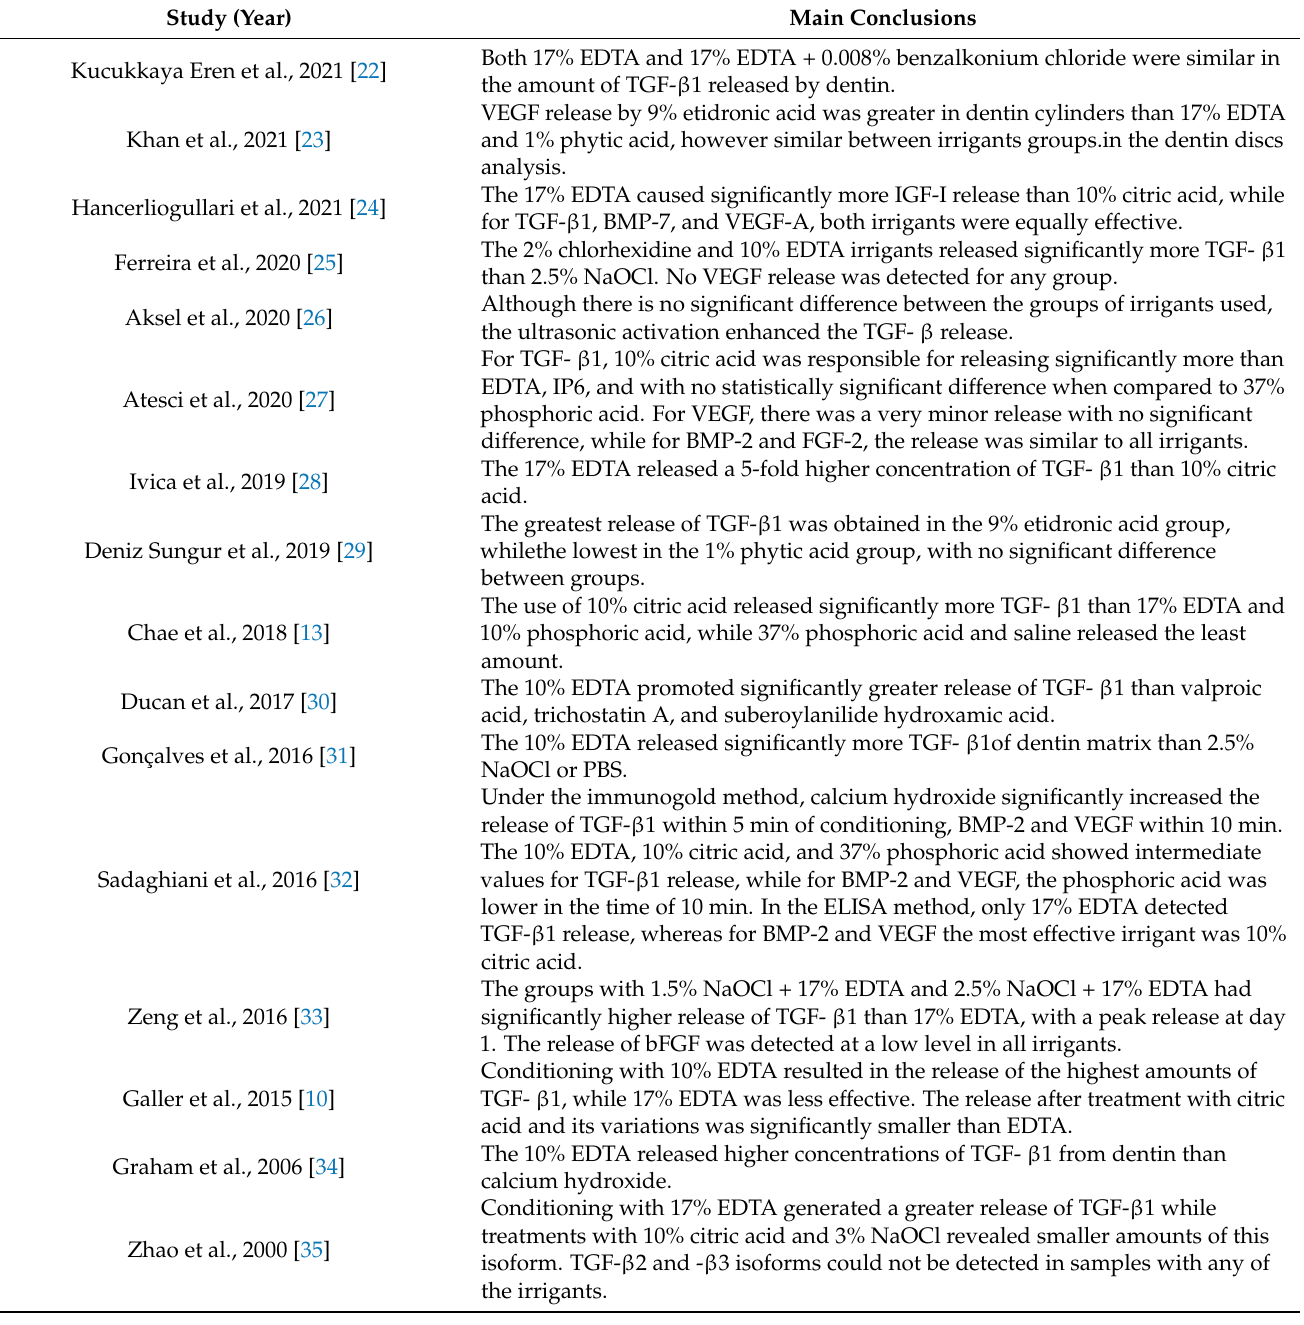
Table 2. Main conclusions of the included